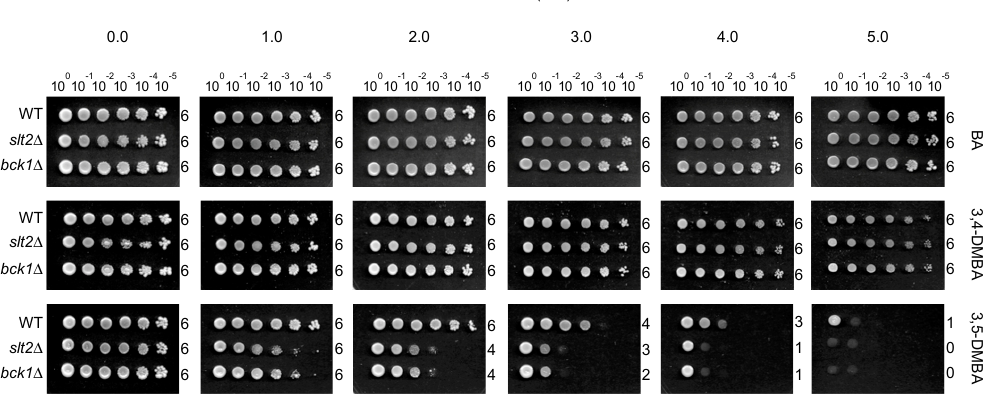
Figure 2. Differential susceptibility of S. cerevisiae strains to benzaldehyde derivatives. Exemplary yeast dilution bioassay showed that S. cerevisiae cell wall integrity mutants ( slt2 Δ , bck1 Δ ) were more